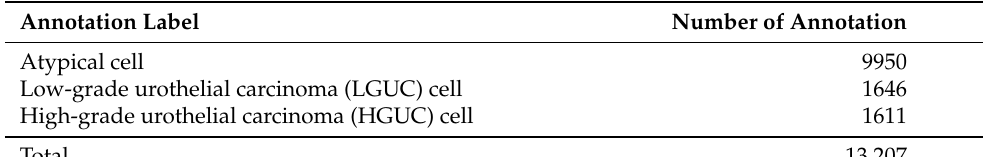
Table 2. Annotation labels and numbers of annotation.